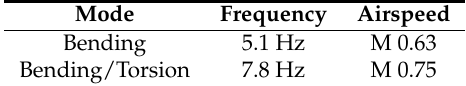
Table 1. Flutter modes and their frequencies.